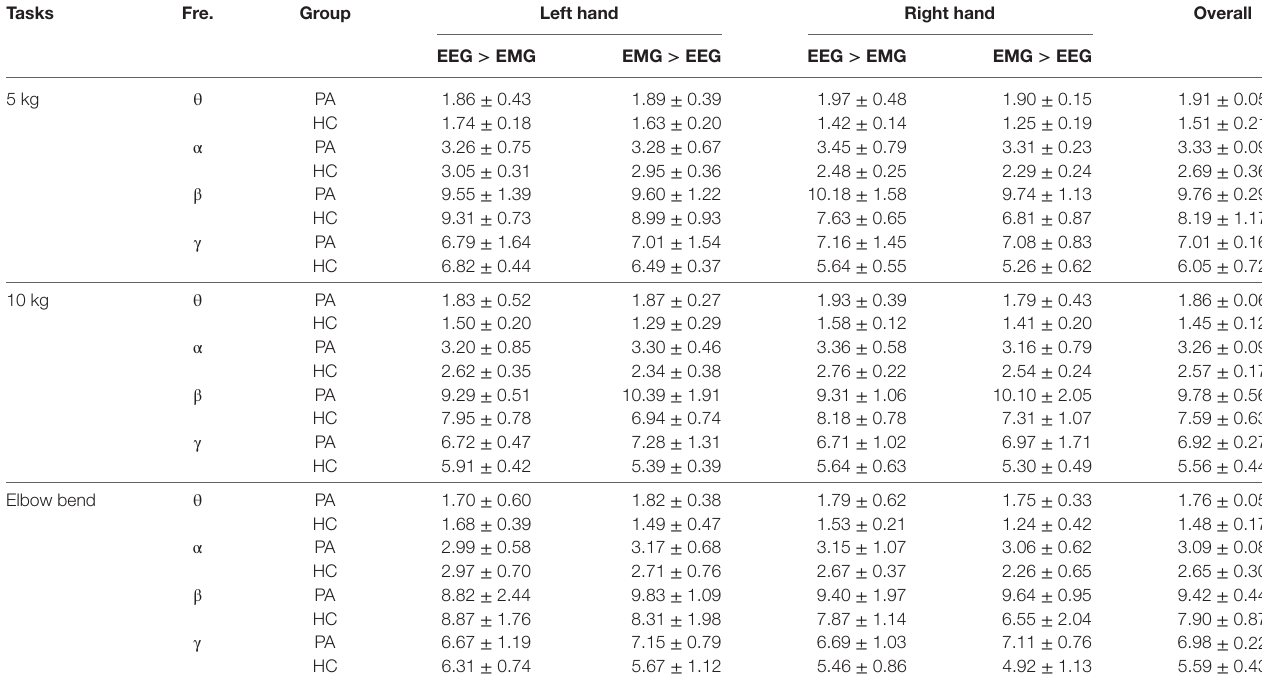
TaBle 3 | Comparison (mean ± SD) of the coupling strength across all subjects. Tasks Fre. group left hand right hand Overall eeg > eMg eMg > eeg eeg > eMg eMg >